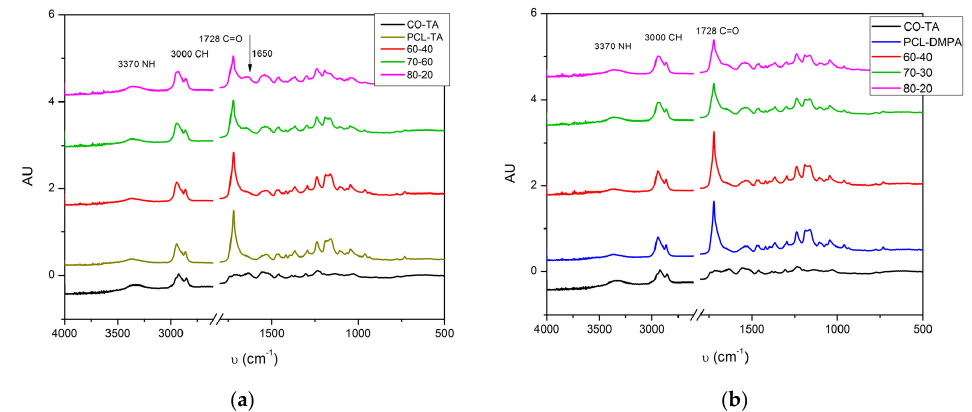
Figure 3. FTIR spectra of the obtained WBPUs and the formulated mixtures: CO-TA/PCL-TA sam- ples ( a ) and CO-TA/PCL-DMPA samples ( b ). ( a ) and CO-TA/PCL-DMPA samples ( b